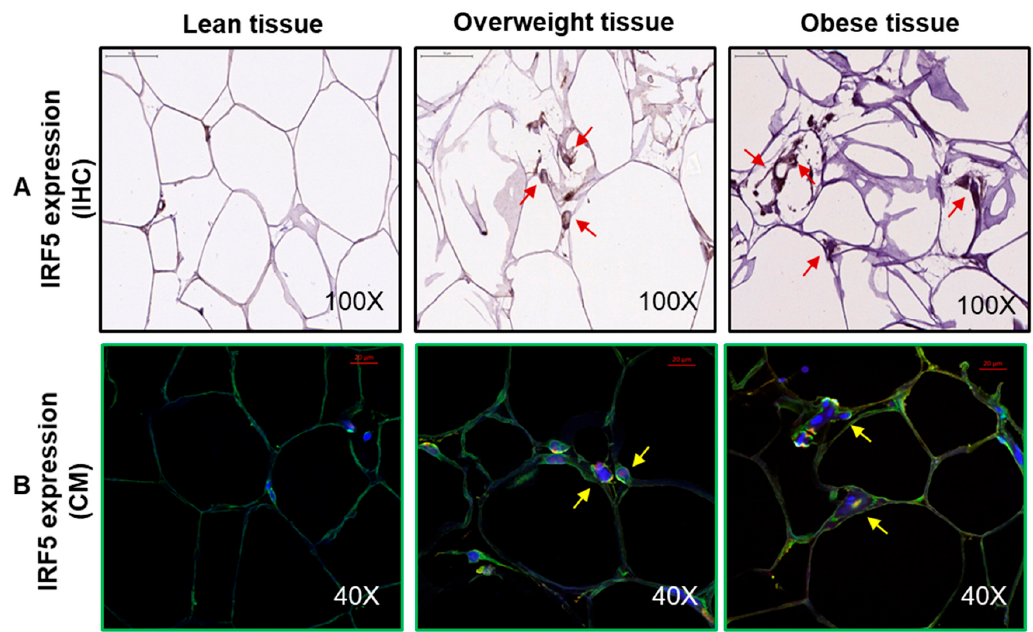
Figure 2. Increased interferon regulatory factor-5 (IRF5) protein expression in the adipose tissue. Adipose IRF5 protein expression was determined by immunohistochemistry (IHC) in six lean, eight overweight, and eight obese individuals and by confocal microscopy (CM), five individuals each, as described in Materials and Methods. The representative images obtained from five independent determinations with similar results show elevated adipose IRF5 protein expression in overweight and obese individuals compared with lean: ( A ) Red arrows in 100× magnification IHC images and ( B ) yellow arrows in 40× magnification CM images. Scale bar = 50 µM.